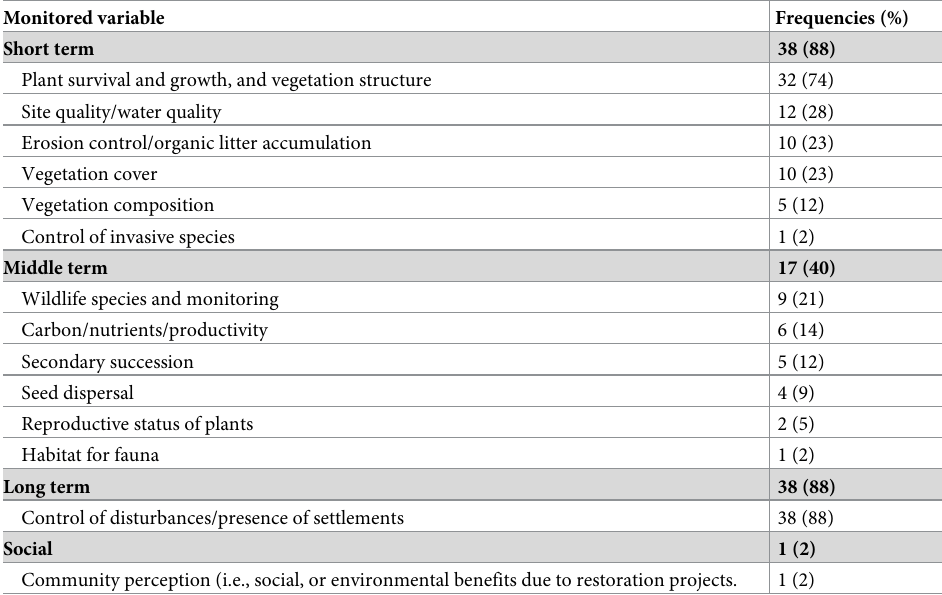
Table 4. Monitored variables.